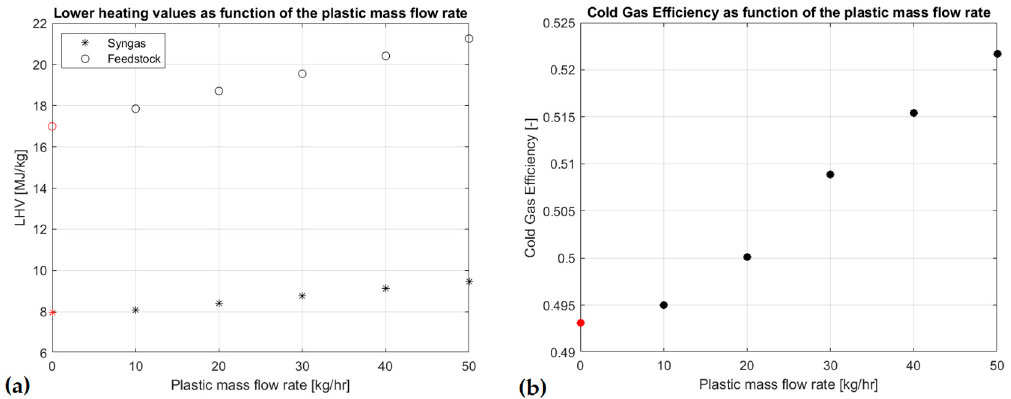
Figure 12. ( a ) Syngas and feedstock LHV as a function of plastic fraction; ( b ) cold gas efficiency as a function of the plastic fraction.